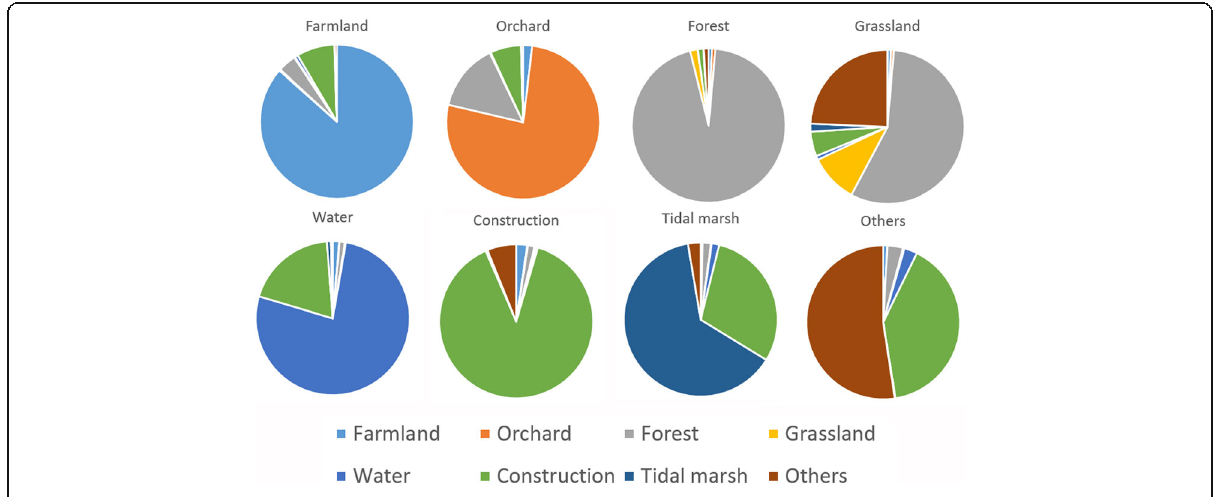
Fig. 3 Land use transition pie chart from 2006 to 2012